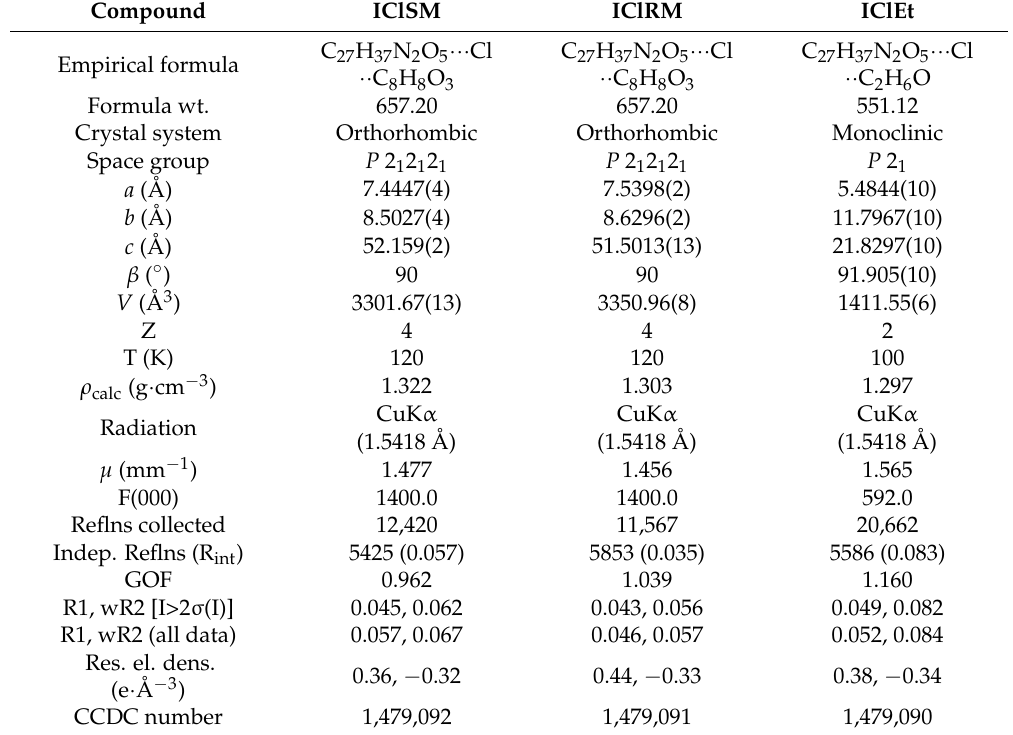
Table 4. Crystallographic data of IClSM, IClRM, and ivabradine hydrochloride ethanol solvate (IClEt). Compound